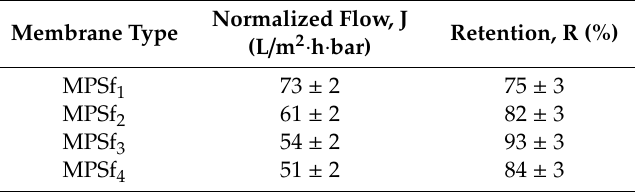
Table 2. Normalized Flow ( J ) and Selectivity ( R ) for the prepared